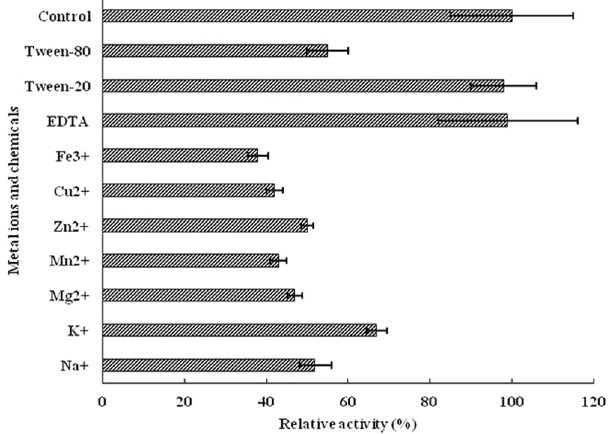
Figure 6. Effect of metal ions and chemical reagents on the activity of purified Est3385 enzyme. Each metal ion was used at a concentration of 1.0 µ mol·ml − 1 , and the concentration of each chemical reagent was used at 1.0%. Relative enzyme activity in a reaction without the addition of metal ions and chemical reagents was set at100%. Each result is the mean of three independent experiments ± standard deviation.